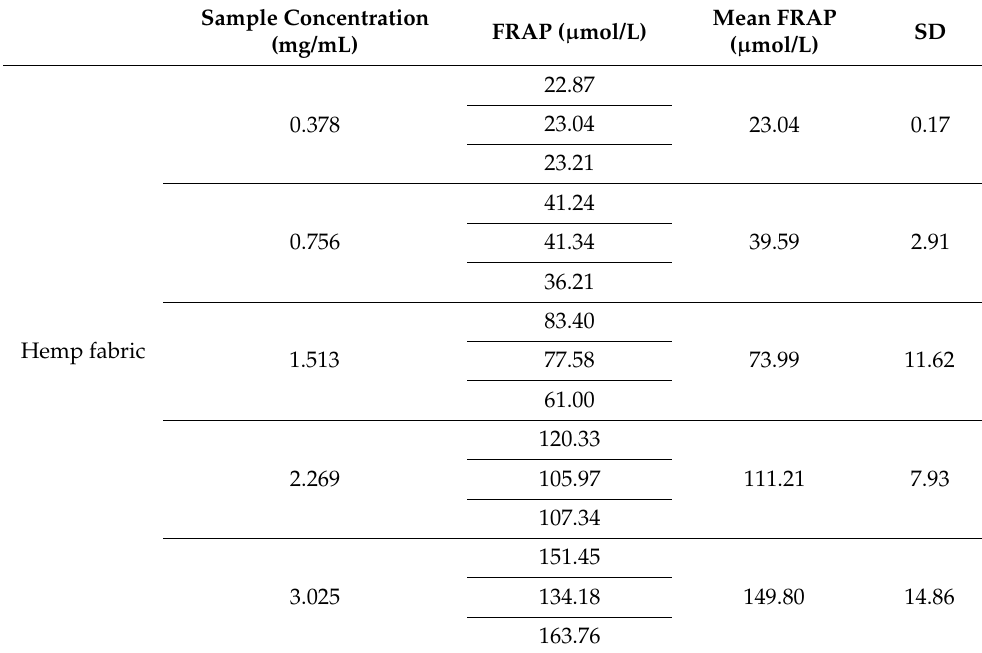
Table 6. Antioxidant activity of pure hemp fabric assessed by the FRAP